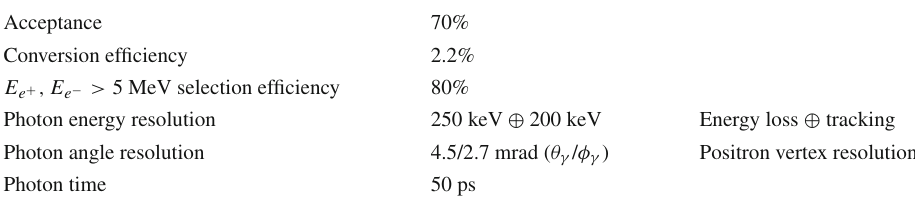
Table 6 Photon reconstruction performances of a baseline μ + → e + γ experiment with photon